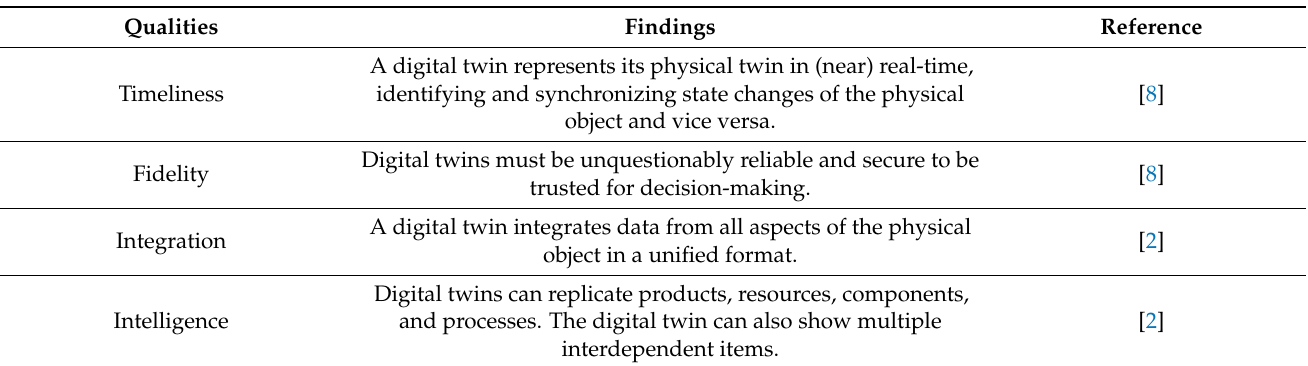
Table 1. Essential traits of digital twin